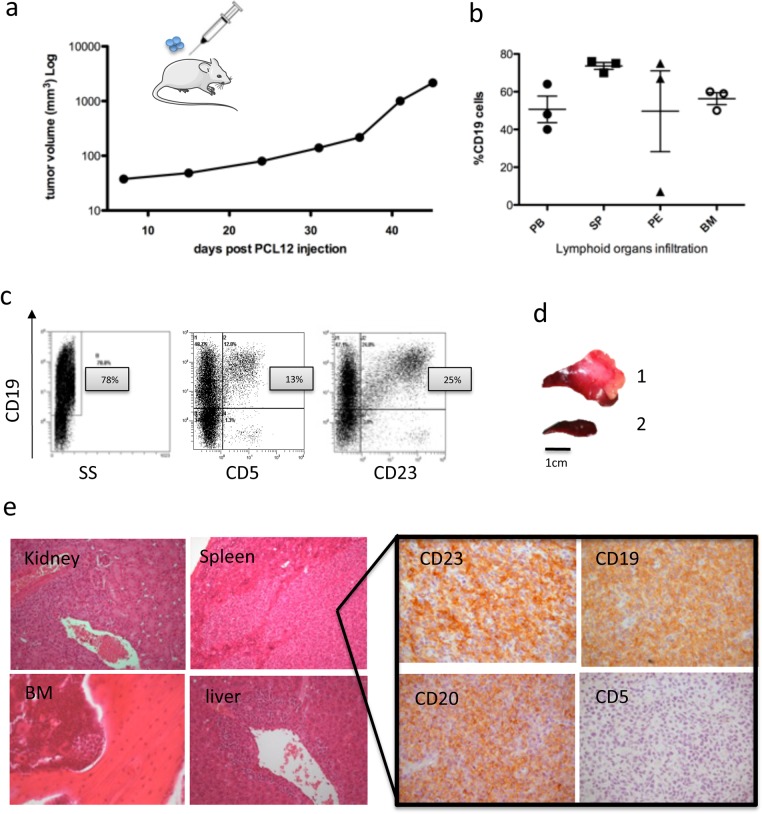
(a) Graph showing the subcutaneous tumor volume grow (b) CD19+ PCL12 cells infiltrating lymphoid organs quantified by flow cytometry in PB, SP, PE and BM.(c) Flow cytometric analysis of PCL12 cells in PB, surface CD19, CD5 and CD23 are represented. (d) images of the representative spleen from 1 mouse injected with PCL12 cells (1) and a WT (2). Histopathological examination of different tissues and IHC analysis.